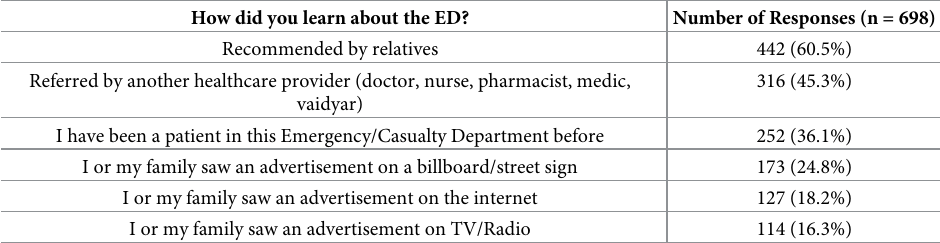
Table 3. How patients learned about the emergency